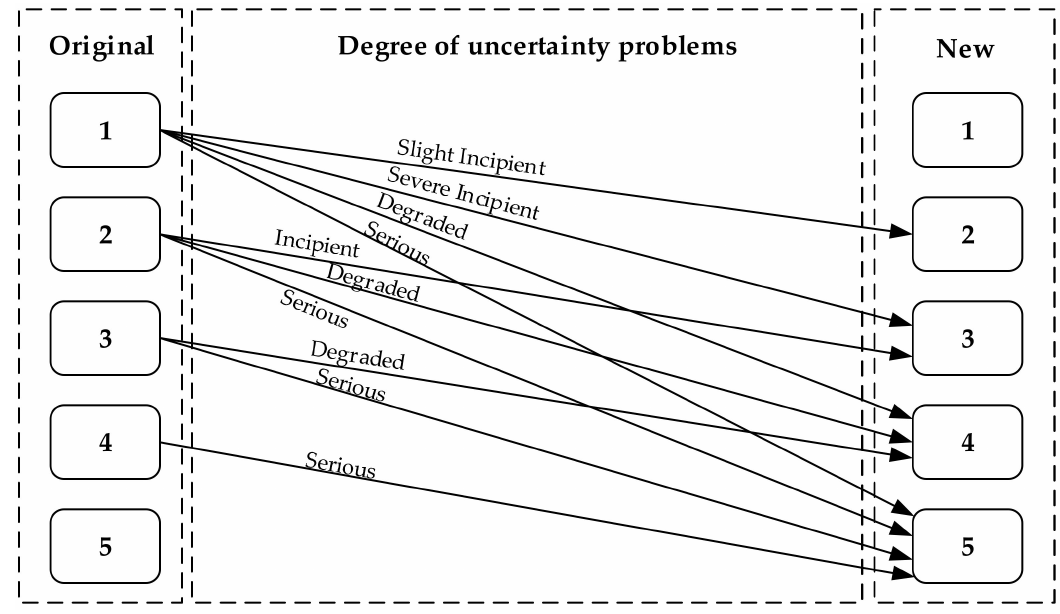
Figure 2. “Failure Cause Probability” change